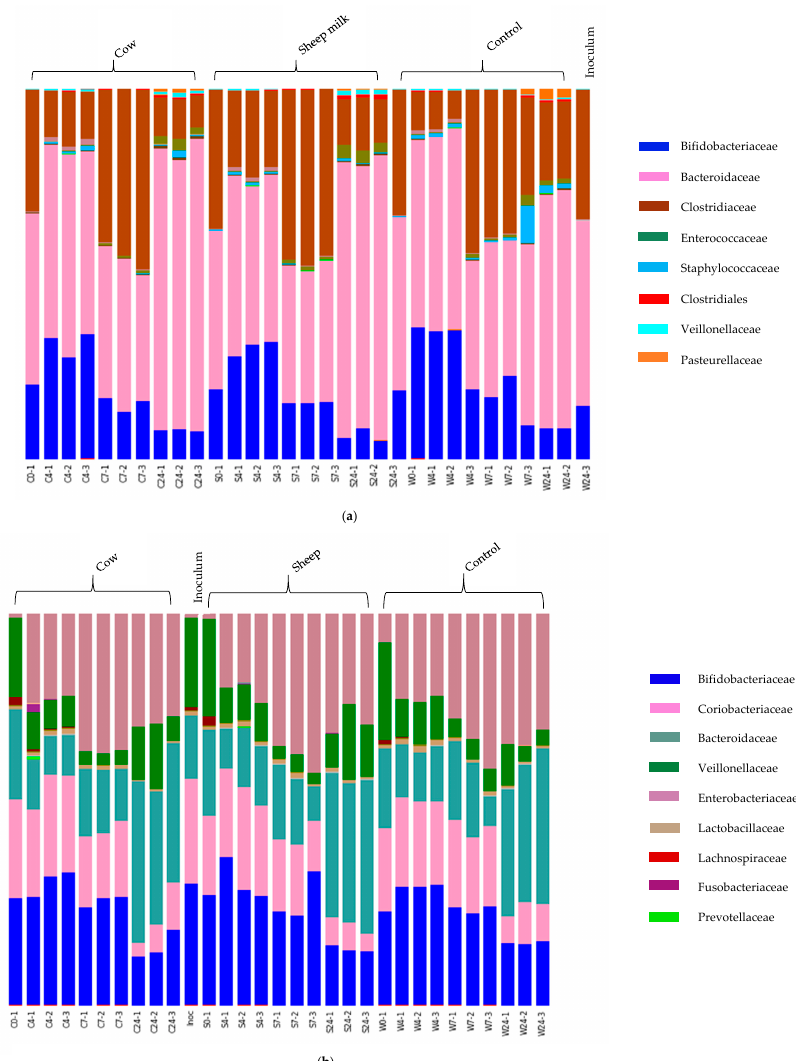
Figure 2. ( a ) One-month old infant faecal fermentation – taxonomic compositions of microbial populations at family level. Bars are labelled by treatment (sheep milk, cow milk or water (control), followed by time point (0, 4, 7 and 24 hours). Two of the dominant families showed significant differences in abundance between sheep milk and cow milk fermentations. These were bacteria of family Bacteroidaceae (genus Bacteroides) and family Clostridiaceae (genus Clostridium sensu stricto 1). ( b ): Five-month old infant faecal fermentation – taxonomic compositions of microbial populations at family level. The bars are labelled by treatment, followed by time point (0, 4, 7 and 24 hours). The dominant families present throughout the fermentation are shown, along with some minor families. The initial dominant bacterial families inhibiting the gut remain dominant throughout the fermentations, although relative abundances of each vary with time and substrate. In the one-month-old infant, the decrease of Bifidobacteriaceae was accompanied by an increase in Clostridiaceae and Bacteroidaceae, with the precise degree of change dependent on incubation time. On the other hand, in fermentations inoculated with the five-month-old feces the loss of Bifidobacteriaceae over time corresponded with an increase in Enterobacteriaceae and Bacteroidaceae. In addition, differences in microbial composition were observed between cultures with sheep or cow milk added as a substrate in fermentations seeded with fecal material from the one-month-old